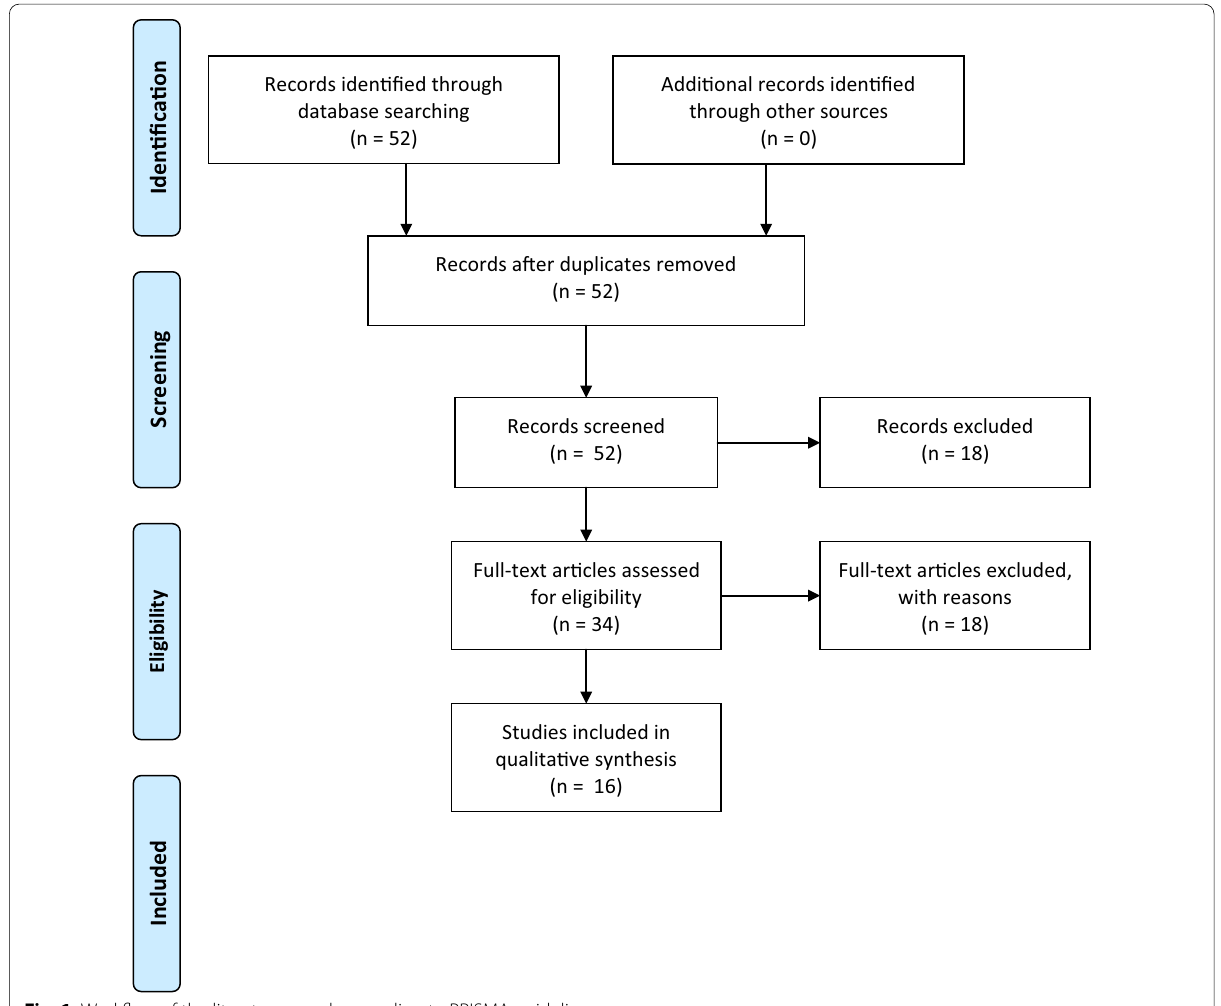
Fig. 1 Workflow of the literature search according to PRISMA